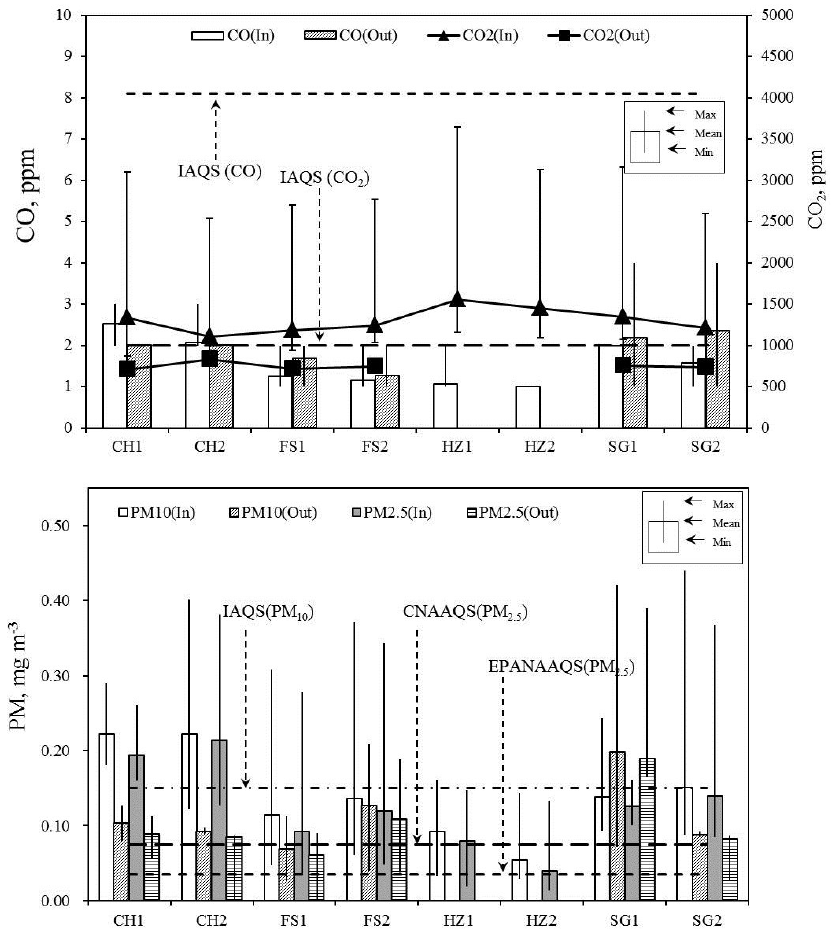
Figure 2. Mean concentrations of CO, CO 2 , PM 2.5 and PM 10 in indoor and outdoor air of four spring hotels. Table 2. Comparison of PM 10 and PM 2.5 in the different indoor environments.